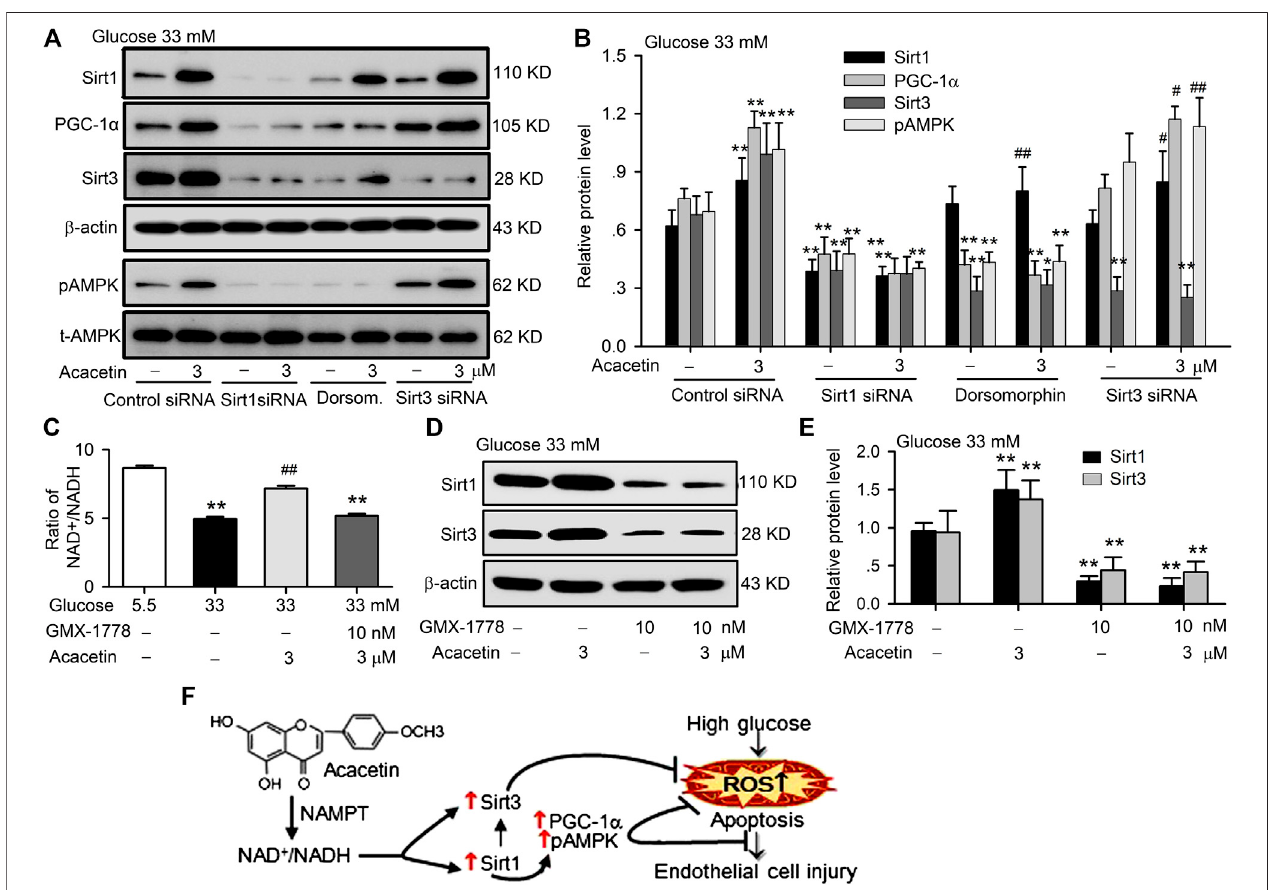
FIGURE 6 | Sirt1 mediates the vascular protection of acacetin against hyperglycemia-induced injury by activating Sirt3/AMPK/PGC-1 α . (A) Western blots of Sirt1, PGC-1 α , Sirt3, pAMPK, t-AMPK in HUVECs cultured with 33 mM glucose and transfected with Sirt1 siRNA or Sirt3 siRNA or treated with the AMPK inhibitor dorsomorphin (Dorsom. 10 μ M) in the absence or presence of 3 μ M acacetin. (B) Silencing Sirt1, but not Sirt3 or inhibition of pAMPK decreased Sirt1 expression and abolishedtheSirt1activationbyacacetin( n (cid:2) 5individualexperiments,** p < 0.01vs.controlsiRNA33 mMglucosealone; # p < 0.05, ## p < 0.01vs.33mMglucose alone). (C) Acacetin reversal of the high glucose-induced reduction NAD + /NADH ratio was decreased by the NAMPT inhibitor GMX-1778 (10 nM) ( n (cid:2) 5 individual experiments, ** p < 0.01 vs. 5.5 mM glucose alone; ## p < 0.01 vs. 33 mM glucose alone). (D) Western blots of Sirt1 and Sirt3 in cells cultured with 33 mM glucose medium in the absence or presence of3 μ M acacetin and 33 mM glucose medium with 10 nM GMX-1778 in the absence or presence of 3 μ M acacetin. (E) GMX-1778 decreased the expression of Sirt1 and Sirt3 proteins and abolished the upregulation of Sirt1 and Sirt3 by acacetin ( n (cid:2) 5 individual experiments, ** p < 0.01 vs. 33 mM glucose alone). (F) Schematic graph shows that acacetin protects against high glucose-induced vascular endothelial cell injury by increasing NAD + /NADH followed by Sirt1-mediated activation of Sirt3/AMPK/PGC-1 α , thereby elevating mitochondrial antioxidation and inhibiting apoptosis.